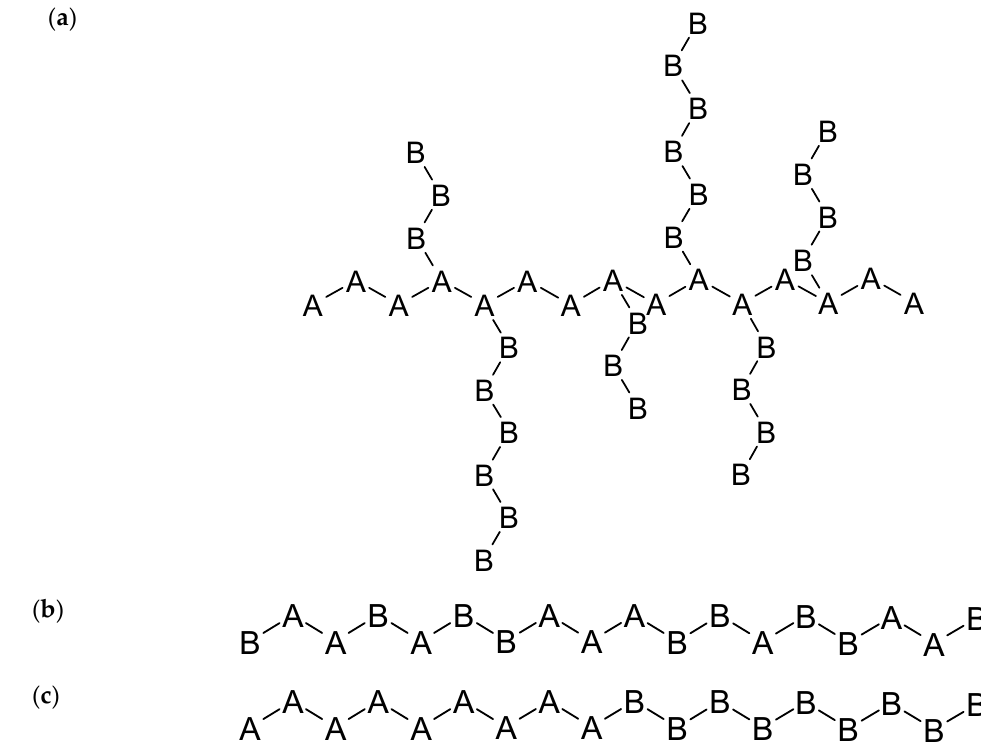
Figure 3. Structure of ( a ) gradient (branched) copolymer, ( b ) random copolymer, and ( c ) block copolymer chains with comonomers A and B.